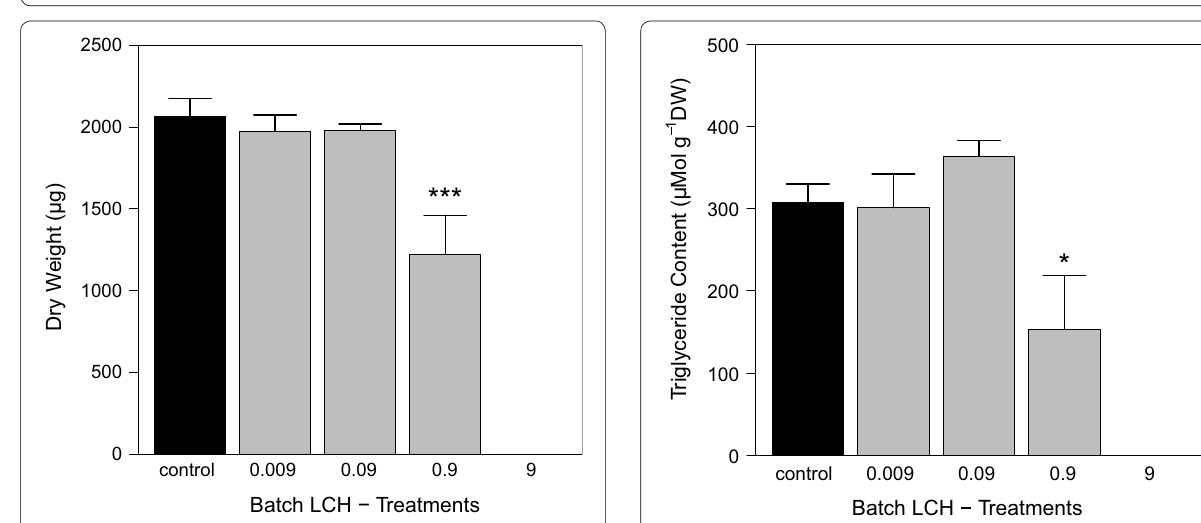
Fig. 13 Grazer dry weights at the end of the LCH batch experiment [mean SE, n 4]. All LCH treatments in µg g − 1 OC. *** significantly ± = different from control with p < 0.001